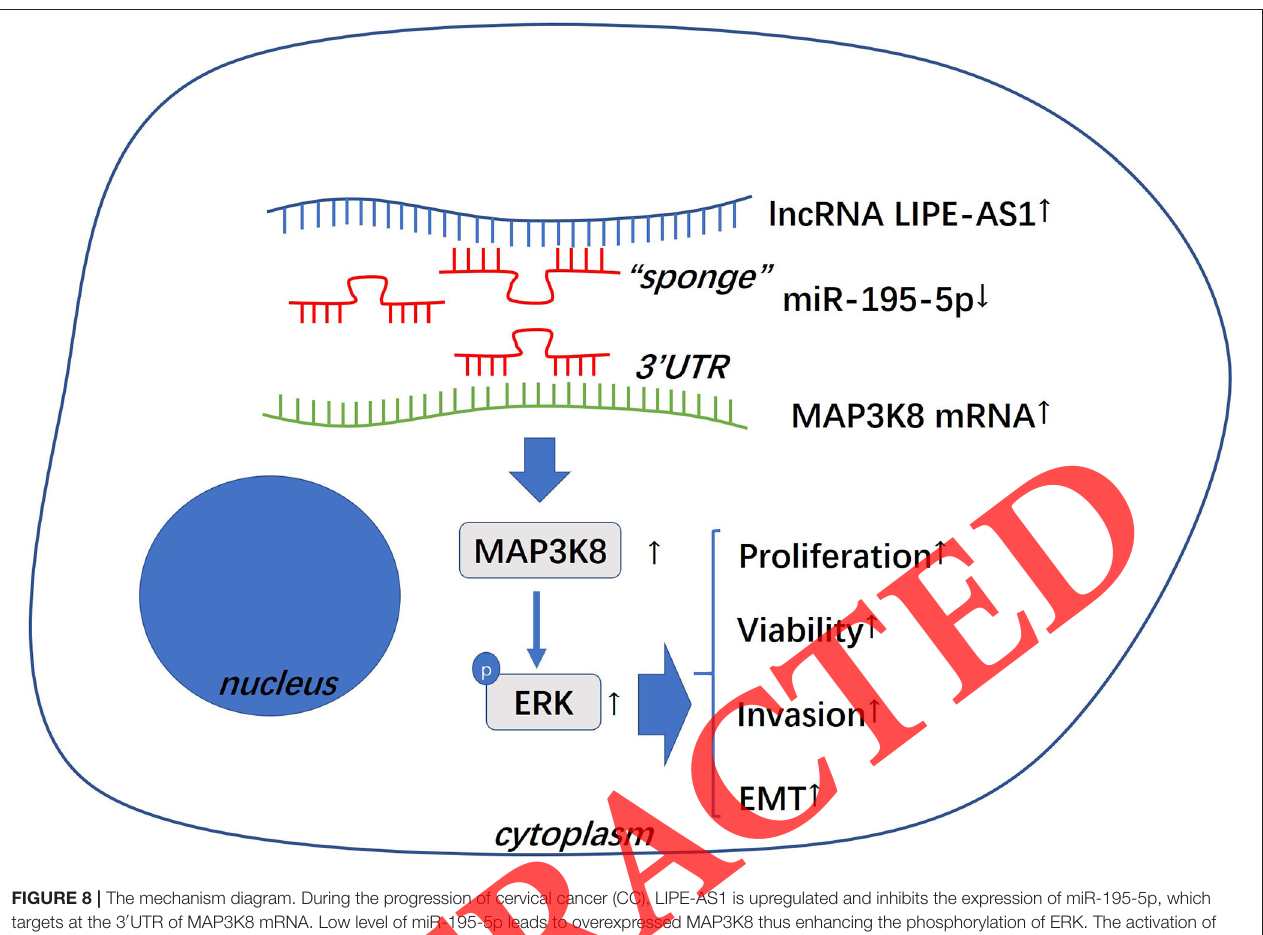
FIGURE 8 | The mechanism diagram. During the progression of cervical cancer (CC), LIPE-AS1 is upregulated and inhibits the expression of miR-195-5p, which targets at the 3 ′ UTR of MAP3K8 mRNA. Low level of miR-195-5p leads to overexpressed MAP3K8 thus enhancing the phosphorylation of ERK. The activation of MAPK/ERK pathway increases the proliferation, viability, invasion, and EMT of CC cells, therefore promoting the development of CC.